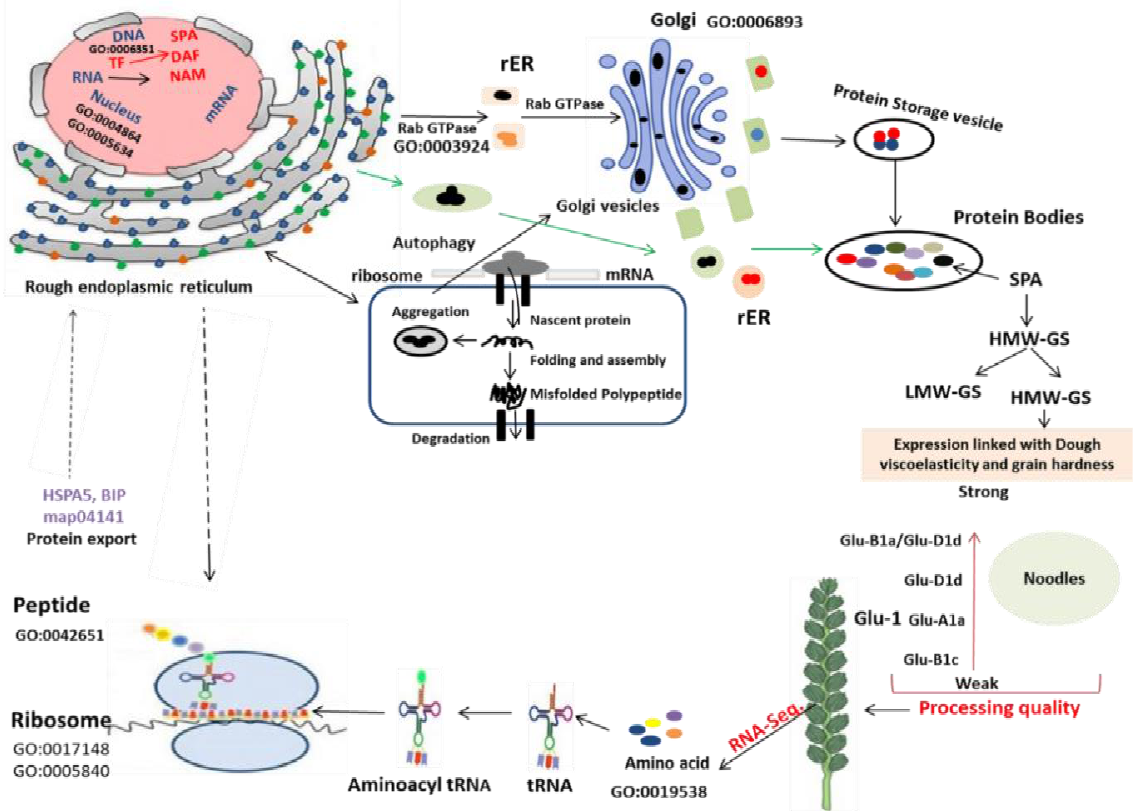
Figure 13. Potential mechanism of protein synthesis and trafficking from ER to Golgi body and ultimate linkage with processing quality characteristics in wheat grain.